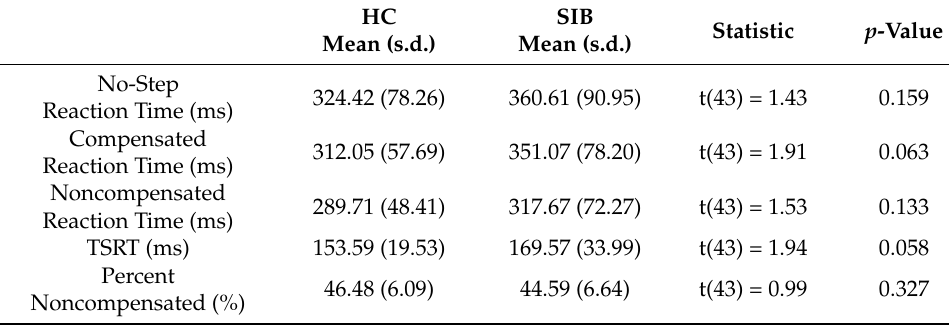
Table 4. Search-step task performance.